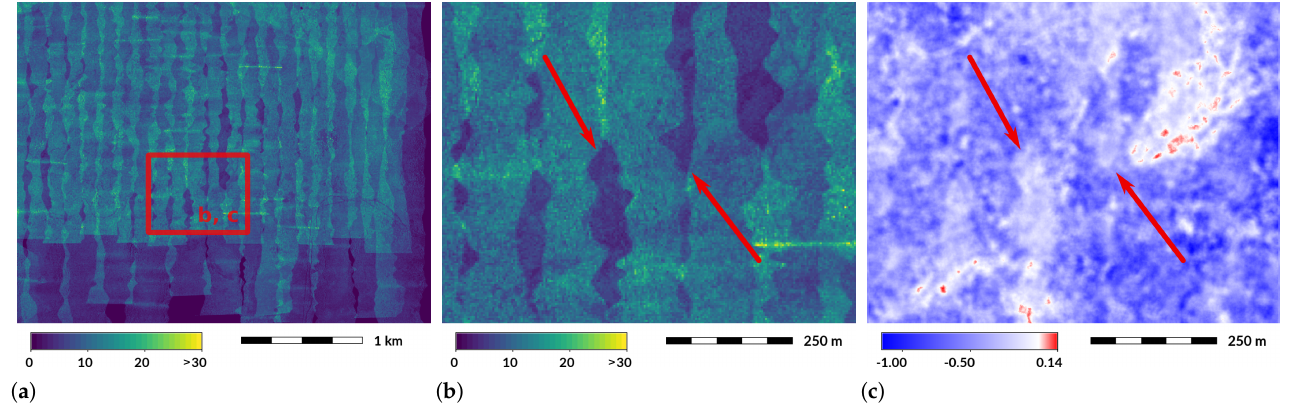
Figure 8. Places with low point density cause differences in skewness of point elevations. ( a ) Larger area showing two sets of north–south swaths. Color represents the number of points per square meter. ( b ) Dark violet areas represent places with low point density ( < 10 points per square meter). ( c ) Skewness of point elevations. Some areas with zero skewness (in white) are associated with areas with low point density. Most prominent places are marked by red arrows. Skewness is smoothed using circular 23x23 moving window to remove local extremes. Dataset: NCALM 2009 [44].